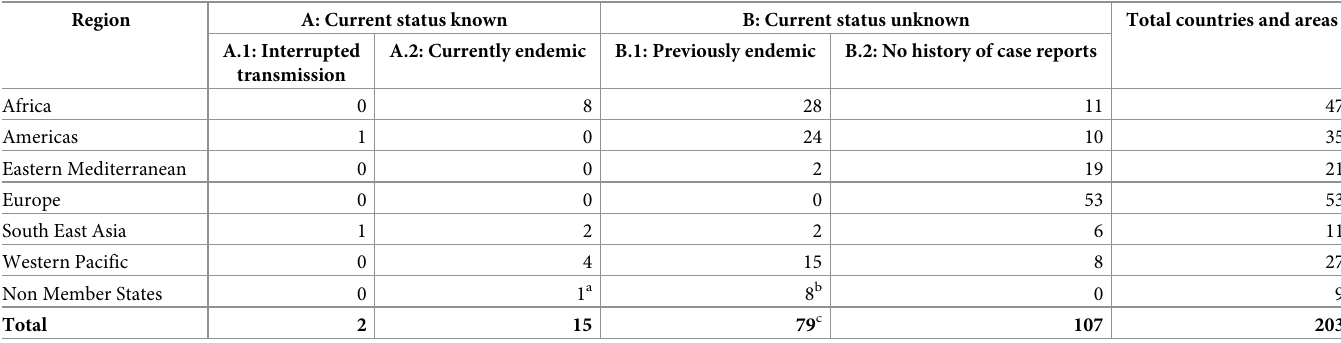
Table 2. Yaws endemicity status by WHO region, 2015. Region